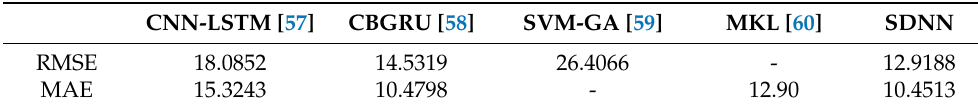
Table 10. Prediction performances of all the models for UCI hourly PM 2.5 concentration time series